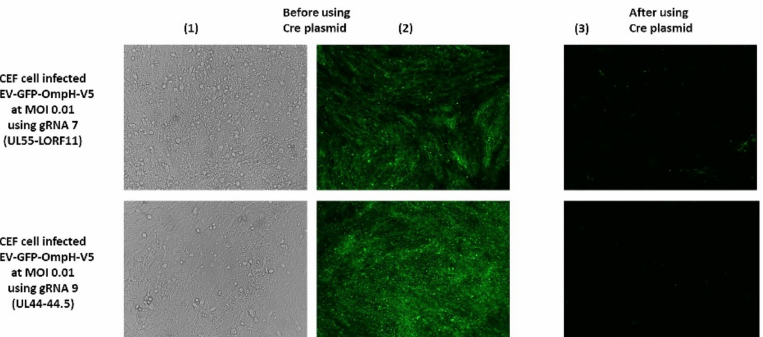
Figure 5. The Excision of the GFP Cassette from DEV-GFP-OmpH-V5 by Cre-Lox system. Before Cre plasmid addition, DEV-GFP-OmpH-V5 plaque under were observed under bright-field ( 1 ) and fluorescent microscopy ( 2 ). After Cre plasmid treatment ( 3 ), this panel shows more than 70% of GFP cassette was removed from the DEV-GFP-OmpH-V5 virus genome. fluorescent microscopy.